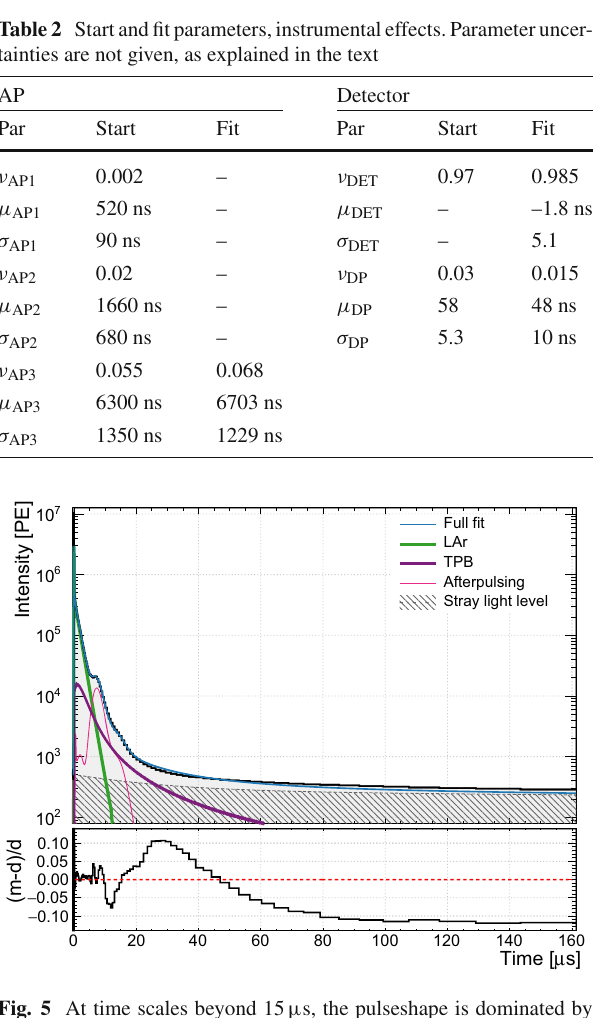
Fig. 5 At time scales beyond 15 µ s, the pulseshape is dominated by the delayed TPB emission. At approximately 30 µ s, the intensity of TPB emission has declined to the point where it is equal to the intensity of left-over late light from previous events the overall normalization I 0 . The resulting parameter values are shown in Fig. 8 on a grid with the test values of t a on the x-axis and the test values of A T PB on the y axis. The fit values for τ t , ν AP 3 , and R T PB are printed in each box, and the box is shaded by the ratio of the given fit’s χ 2 to